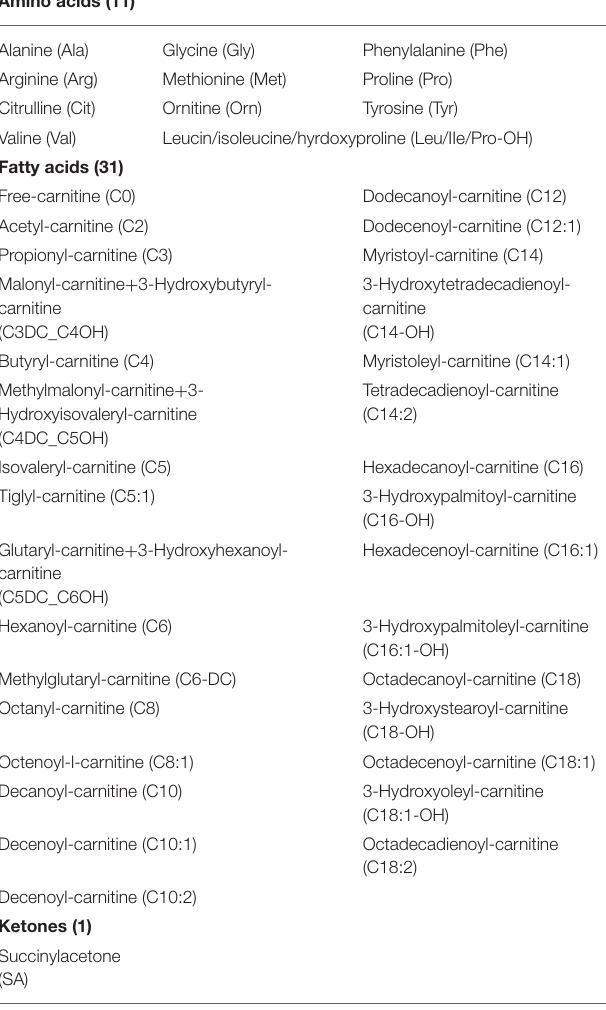
TABLE 1 | Metabolites detected by MRM analysis in newborn screening.